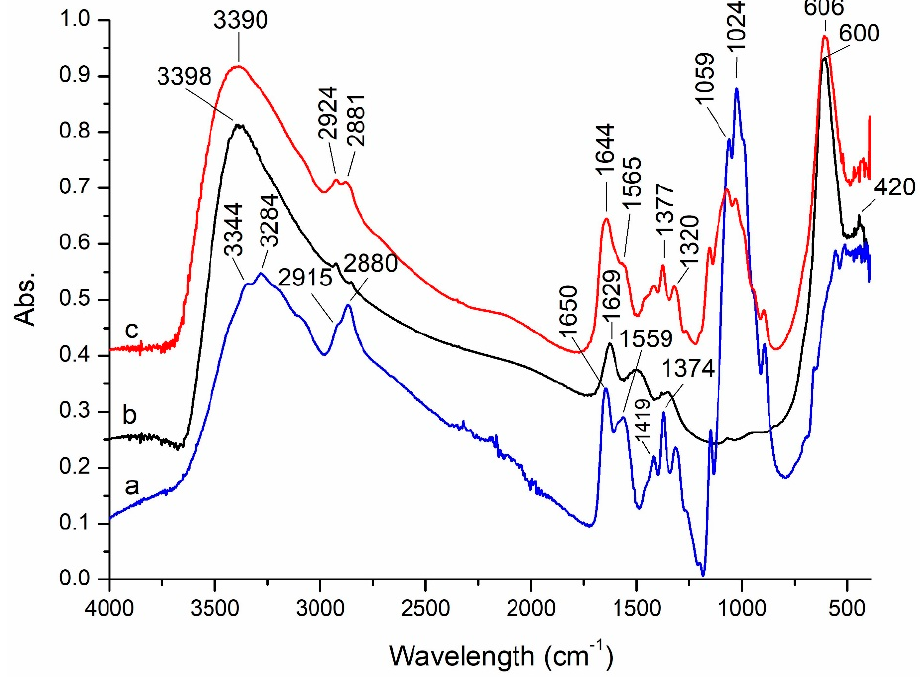
Figure 2. FTIR spectra of: (a) chitosan; (b) CoFe 2 O 4 ; (c) CoFe 2 O 4 − Chit. The FTIR spectrum of chitosan displays two absorption bands at 3344 and 3284 cm − 1 assigned to -OH and -NH 2 stretching vibrations, and two bands at 2915 cm − 1 due to the asymmetric C-H stretching vibrations and 2880 cm − 1 corresponding to symmetric C-H stretching vibrations. The peaks at 1650 and 1559 cm − 1 are related to the C=O stretching vibration of amide and the bending vibration of NH 2 groups, respectively [35]. The bands located at 1374 and 1024 cm − 1 are characteristic for C-O stretching vibration of C-OH [36] while that at 1419 cm − 1 is characteristic for –OH primary alcohol groups